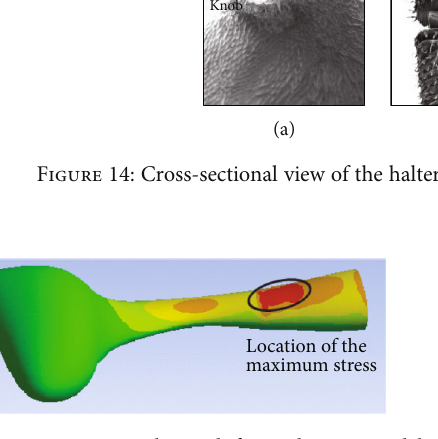
Figure 15: Stress variation obtained from the FE model with variable cross-section into